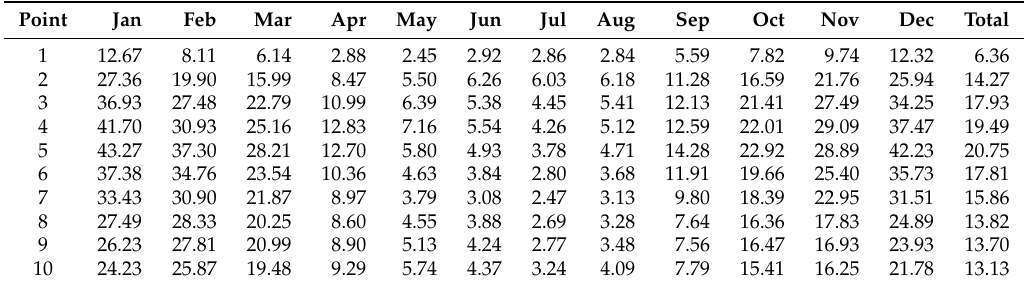
Table 3. Average monthly WEF w (kW m − 1 ) for the 10 selected